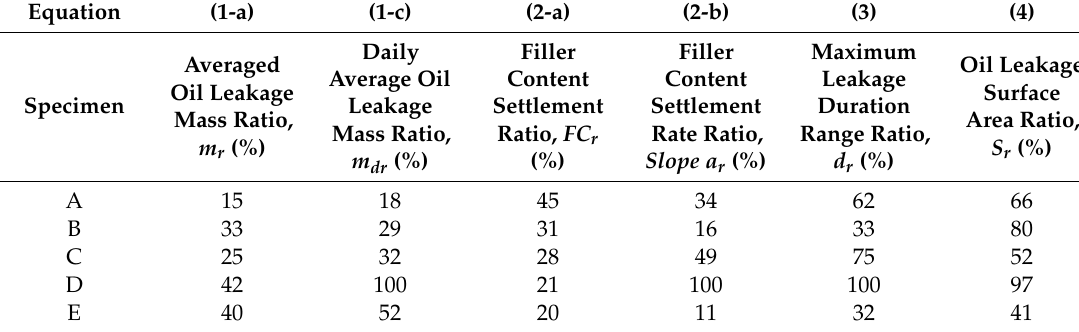
Table 19. Ratio results of each evaluation